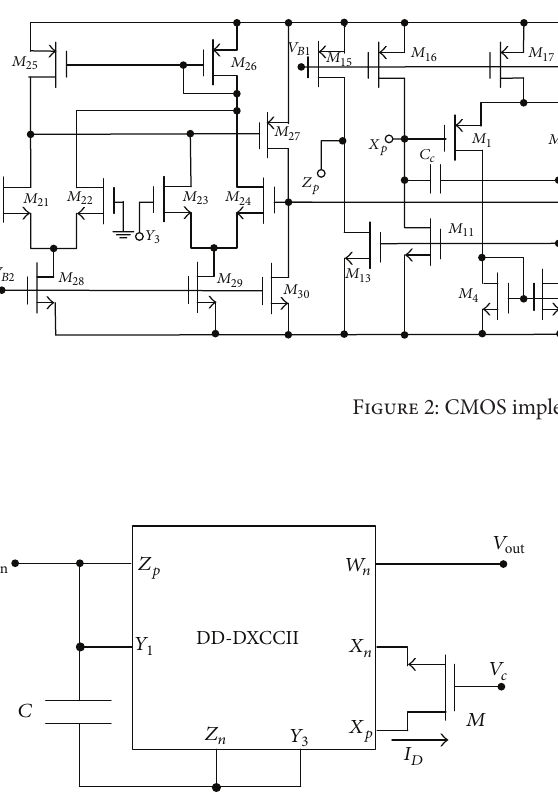
Figure 3: Proposed tunable first-order all-pass